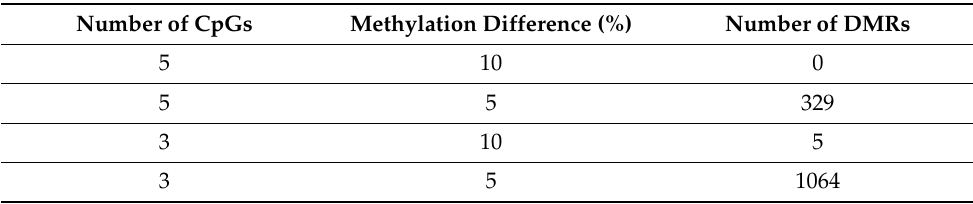
Table 1. Number of differentially methylated regions (DMRs) identified between 22q11.2DS cases and controls.